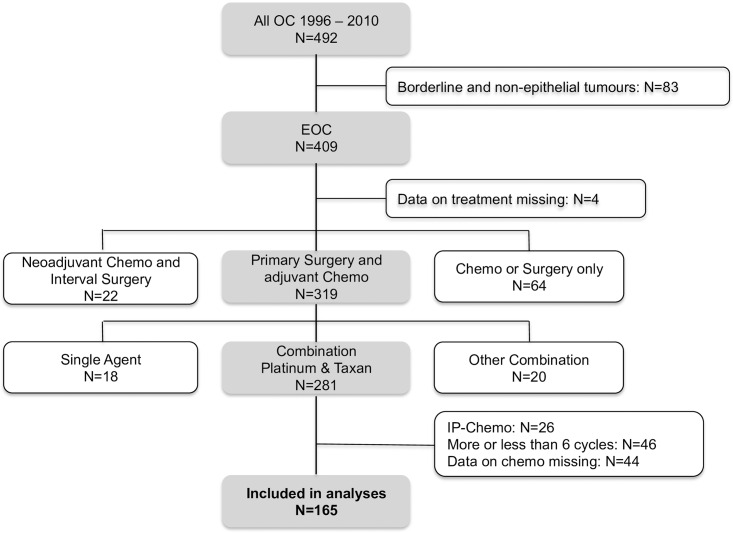
Flowchart.The process of inclusion and exclusion of patients in order to find the sample of patients included in the present study (= 165).